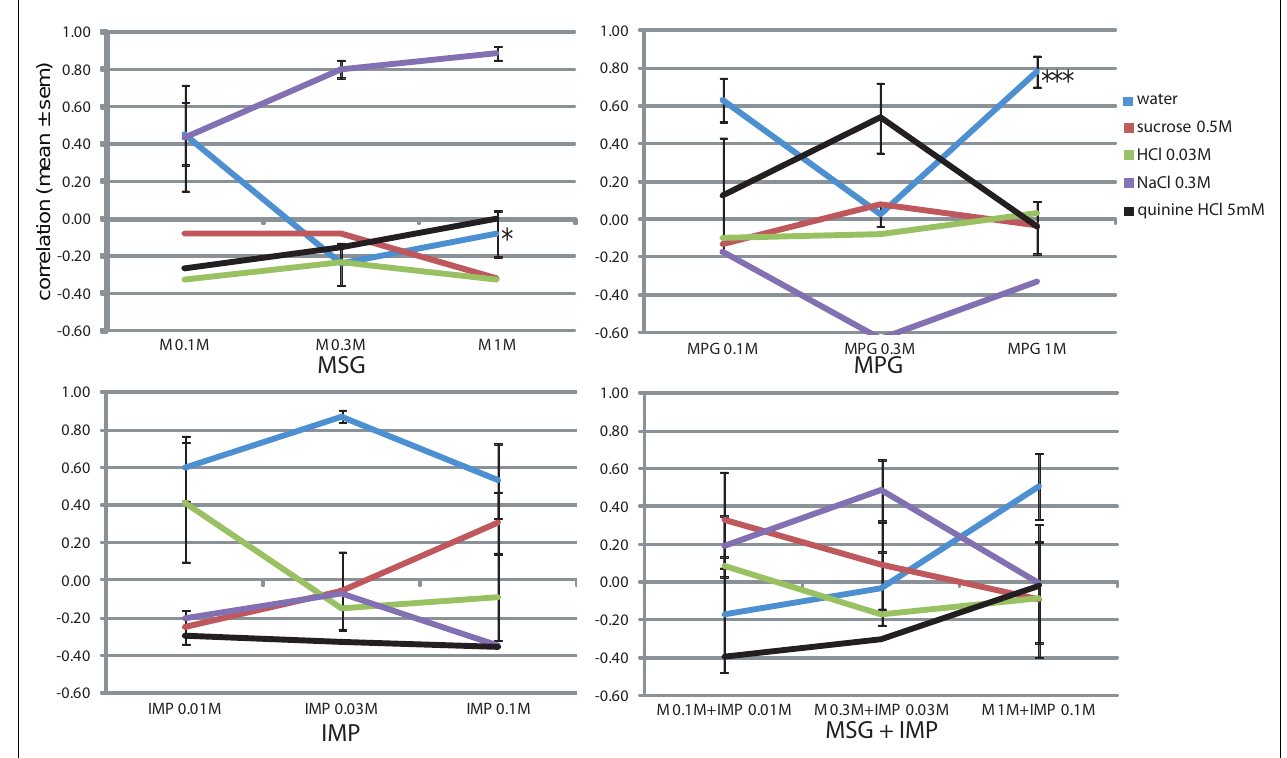
FIGURE 5 | Concentration–response generalization curves of umami stimuli. * P < 0.05, ** P < 0.01, *** P < 0.001 (MANOVA on concentration).